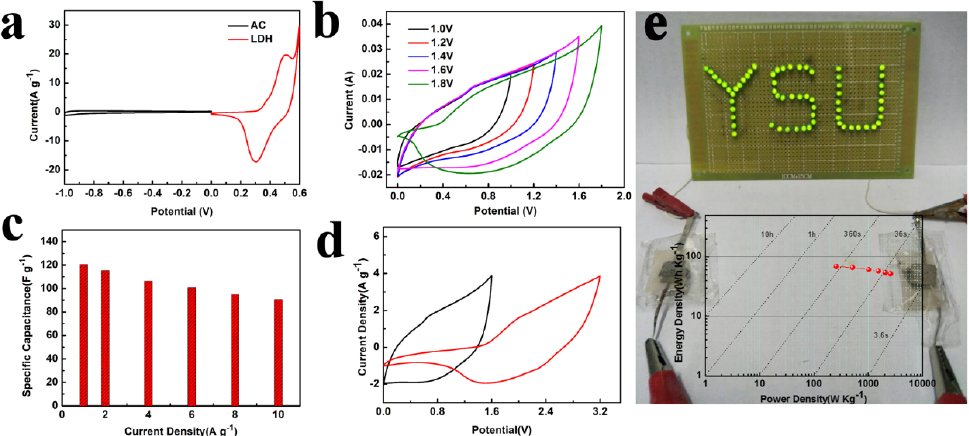
Figure 6. ( a ) CV curves of AC electrode and NiCoAl-OH electrode at a scan rate of 5 mV s − 1 . ( b ) CV curves of NiCoAl-OH//AC device under different voltage windows. ( c ) The specific capacity of the NiCoAl-OH//AC device at different current densities. ( d ) CV curves of a single hybrid device and two hybrid devices connected in series. The single device can sustain 1.6 V, such that the series connection of two capacitors can supply output potential up to 3.2 V. ( e ) Photographs of two hybrid devices connected in series, which can drive 64 green light-emitting diodes (LEDs) and Ragone plot of the NiCoAl-OH//AC